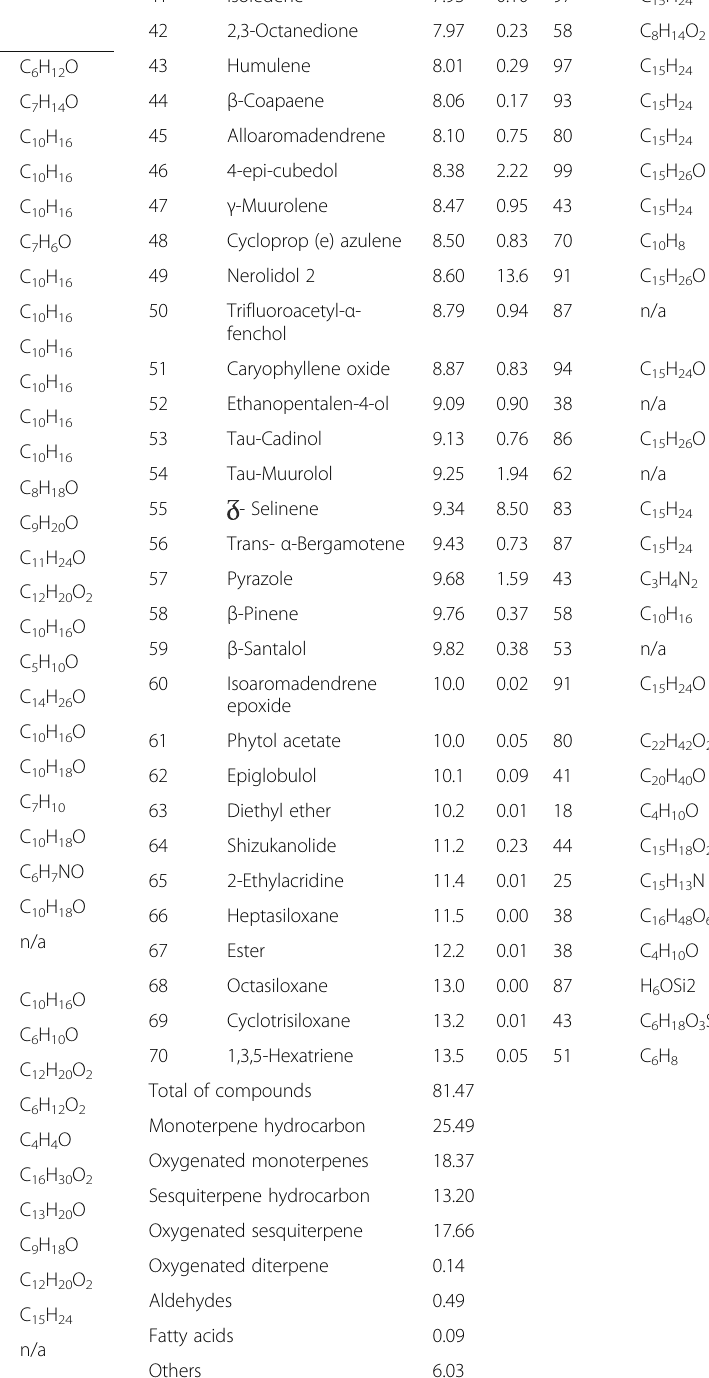
Table 3 Chemical compounds of Cymbopogon plurinodis leaf GC peak